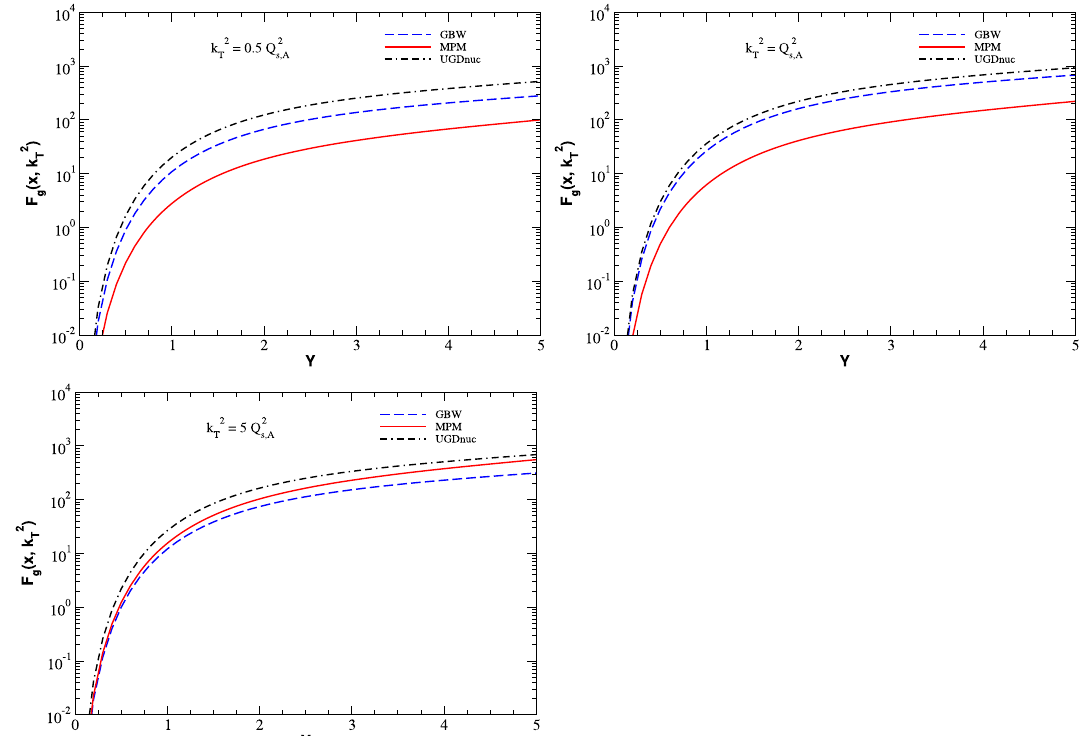
= 0 . 5 Q 2 = Q 2 , k 2 , T s , A T s , A